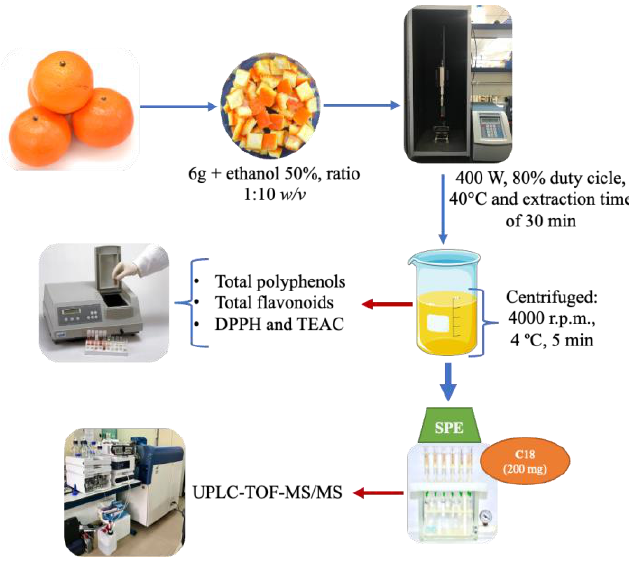
Figure 1. Mandarin peel extraction and polyphenol analysis.